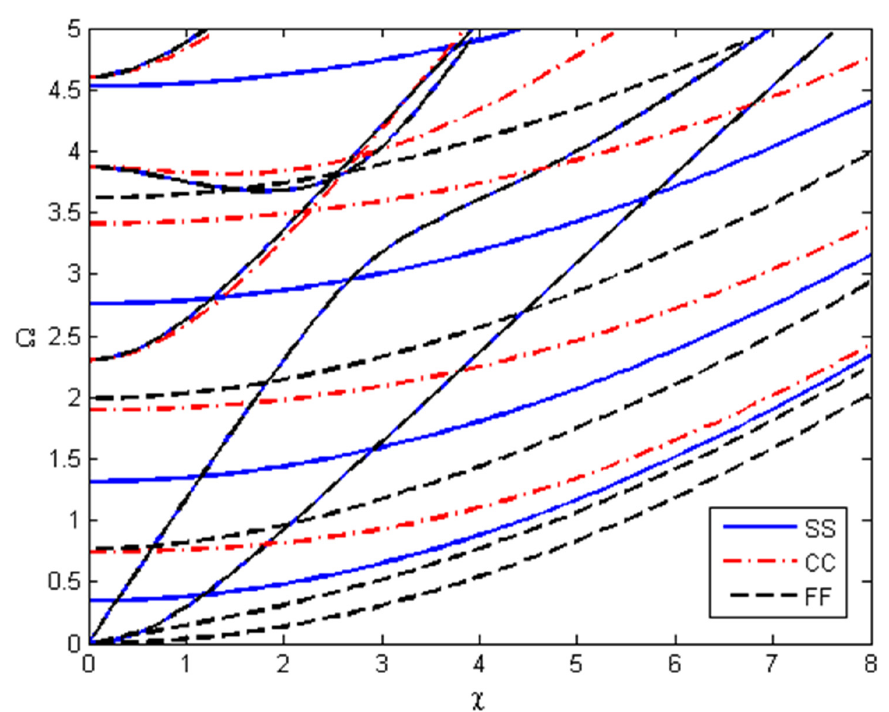
Figure 6. Effect of boundary condition on the dispersion spectra of GPLs reinforced plates.